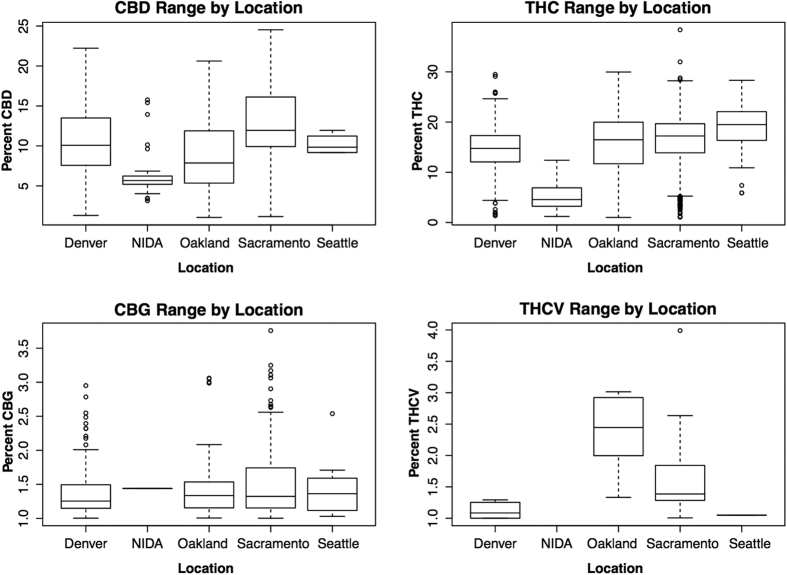
Median and range for cannabinoids by location.Median (line within the box), 25th and 75th percentile (bottom and top of the box respectively), and range (bars outside the box). Outliers are dots outside the box and range. The Y axis differs by panel.